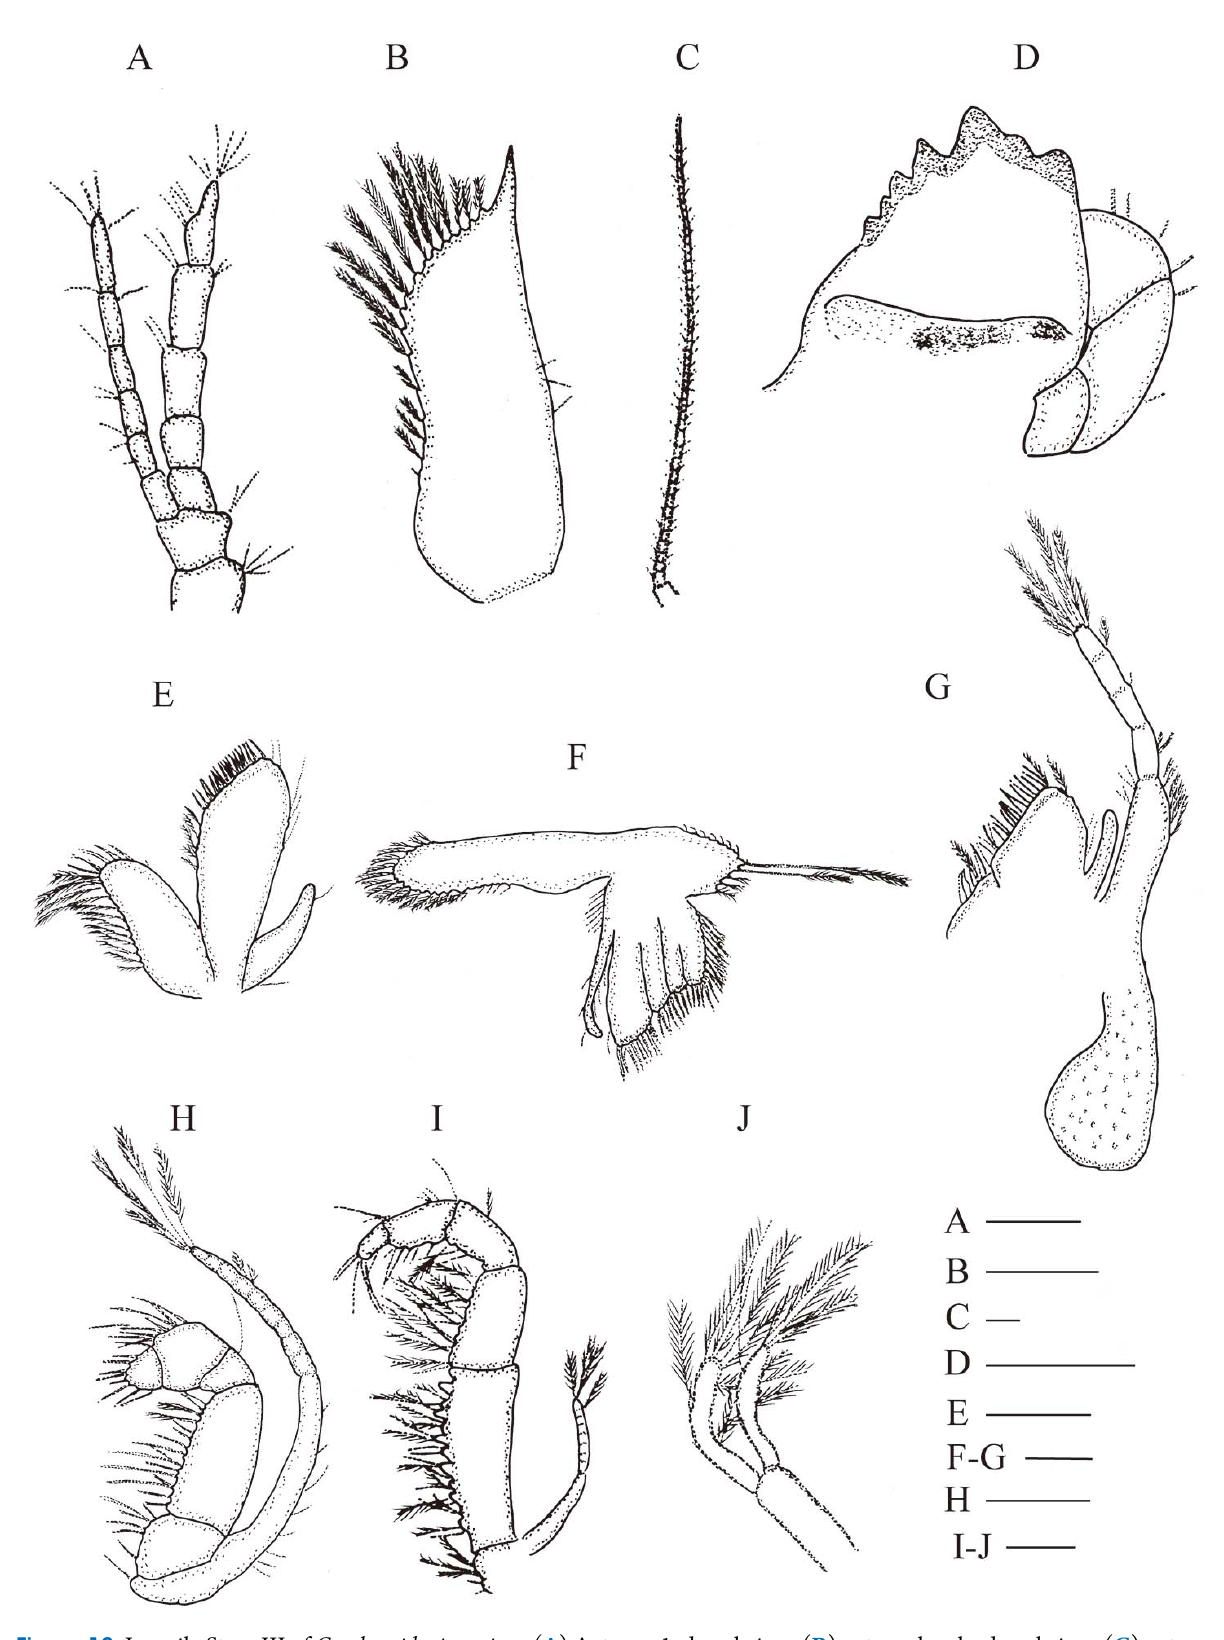
Figure 18. Juvenile Stage III of Cambaroides japonicus . ( A ) Antenna 1, dorsal view; ( B ) antennal scale, dorsal view; ( C ) antenna 2, dorsal view; ( D ) mandible, view of inside of mouth; ( E ) maxilla 1, oral view; ( F ) maxilla 2, oral view; ( G ) first maxilliped, oral view; ( H ) second maxilliped, oral view; ( I ) third maxilliped, oral view; ( J ) pleopod. Scale bars: 0.25